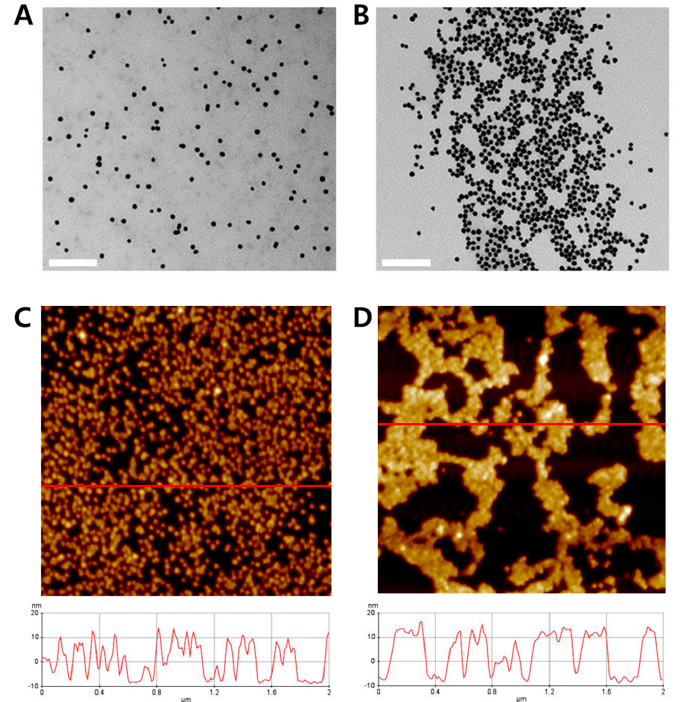
Figure 3. Transmission electron microscopy (TEM) images and atomic force microscopy (AFM) analysis results of: the non-reaction sample with AuNP probes alone ( A , C ); and RCA reaction sample with AuNP probes ( B , D ), respectively. The length of the inset scale bar in the TEM images is 200 nm. The horizontal red lines of the AFM images indicate the analysis range of height profile, and lower graphs of the AFM images indicate the height profiles of each sample.